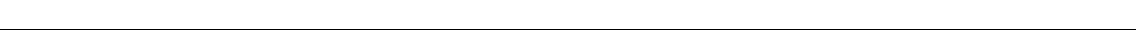
Figure 2 | Characterizations of protein interactions in the Vta1-free and the Vta1-bound Vps4 E233Q hexamers. ( a ) Comparison of six pairs of the adjacent Vps4 E233Q subunits. The colouring scheme is the same as in Fig. 1c,e. When one Vps4 E233Q molecule (shown in ribbon representation) from each pair of the adjacent subunits aligned with each other, the other one (shown in cartoon representation) is also well aligned, except for the pairs involving subunit A (red arrow). ( b ) A focused view of the domains that mediate the interactions between the Vps4 E233Q monomers (subunits C and D). Three boxed intermonomer interfaces are detailed in c – e . ( c – e ) The close-up views of the interfaces between the large ATPase domains ( c ), the large and small ATPase domains including the b -domain ( d ) and the C-terminal helixes ( e ). Potential residues participated in the interactions are represented by spheres. Hydrophobic, aromatic, positively charged and negatively charged residues are coloured grey, pink, blue and red, respectively. The orientations of all close-up views are optimized to show the interactions. ( f – h ) SEC analyses of the oligomeric states of the Vps4 E233Q mutants targeting the interface between the large ATPase domains ( f ), the large and small ATPase domains including the b -domain ( g ) and the C-terminal helixes ( h ). ( i ) A focused view of the interactions between the Vta1 CTD dimer (subunits I and J) and the adjacent Vps4 E233Q subunit pair (subunits C and D). Two different contact modes are highlighted by purple and blue dashed circles, respectively, and detailed in j , k . ( j , k ) The close-up views of the interactions between the Vps4 E233Q subunit D and the CTD dimer ( j ), and the Vps4 E233Q subunit C and the CTD dimer ( k ). ( l , m ) Assessments of the interactions by SEC between Vta1 and Vps4 mutants, E233Q and E233QR325A, at high concentration (100 m M) in the absence of ATP ( l ), and at low concentration (5 m M) in the presence of ATP ( m ). ( n ) Assessment of the stabilities of the Vta1-free Vps4 E233Q hexamer and the Vta1-bound Vps4 E233Q hexamer formed by different Vps4 mutants with or without apyrase treatment by SEC (See Methods for